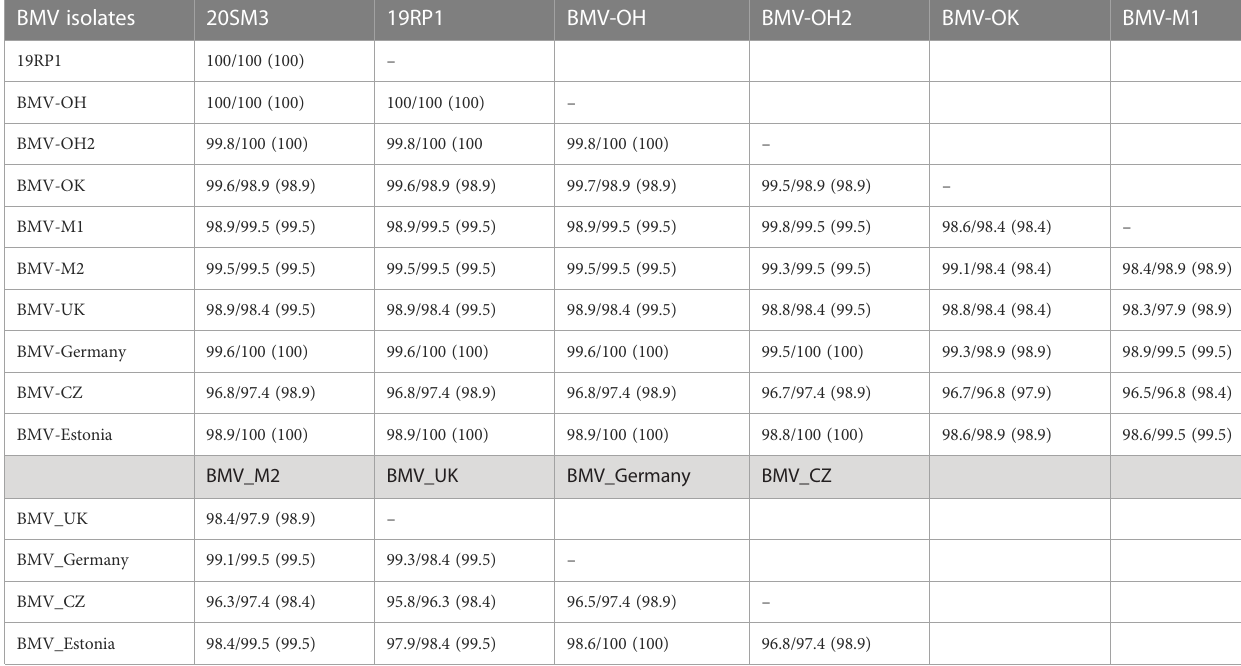
TABLE 4 Nucleotides/amino acid sequence identity (similarity) of RNA4 (coat protein, CP) genome of brome mosaic virus (BMV) isolates from Kansas and other known BMV isolates retrieved from GeneBank. BMV